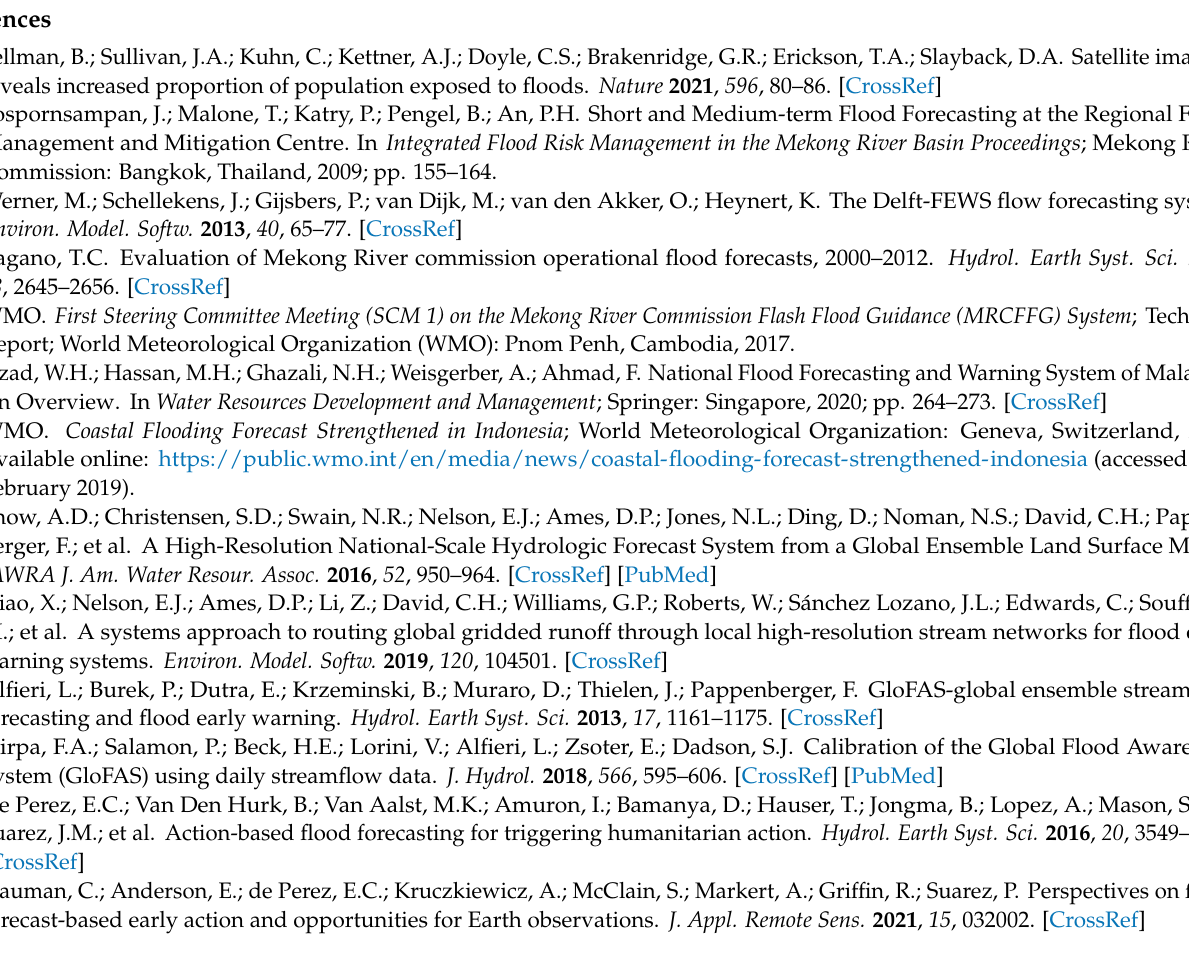
Figure A4. Plot of precipitation taken from CHIRPS [73] and the observed discharge. For visualization purposes, the data are downsampled into a weekly bin, and the mean values are shown. The left y-axis is for discharge (blue plot), and the right y-axis is for precipitation (orange